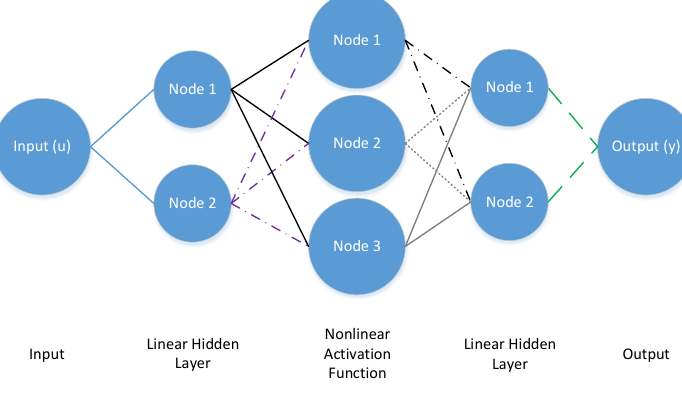
Figure A1. Neural network structure.